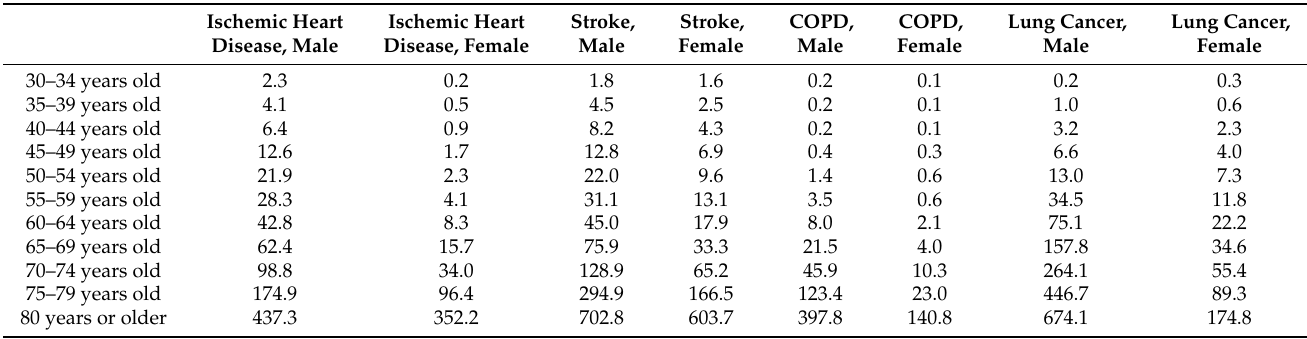
Table A1. 2019 deaths per 100,000 people by gender in each age bracket due to ischemic heart disease, stroke, chronic obstructive pulmonary disease (COPD), and lung cancer in South